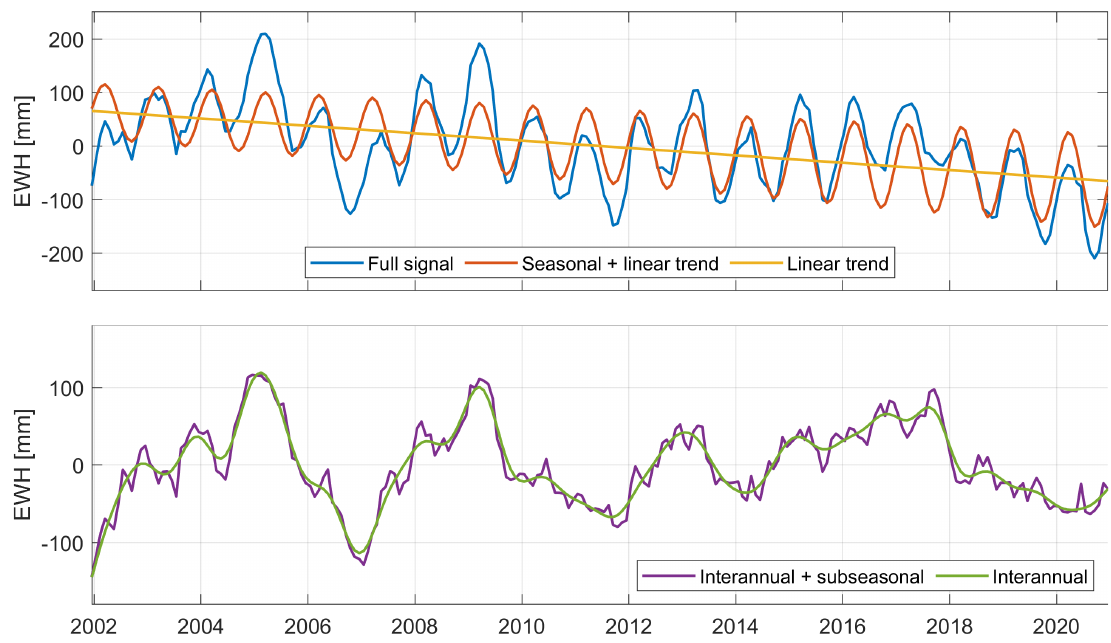
Figure 1. Example for the decomposition of a mTWS time series into linear trend, seasonal, subseasonal and interannual signal. The location is 13 ◦ E and 52.5 ◦ N (Potsdam, Germany), the model is GFDL-CM4 (r1i1p1f1